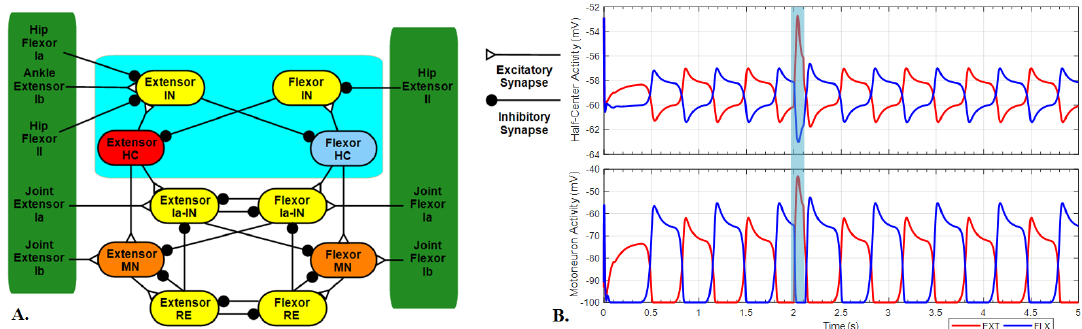
Figure 1. ( A ) Single limb joint control network. ( B ) Neuron activities of half-center neurons and motoneurons without feedback. Excitatory stimulus with a current of 2 nA applied to an extensor half-center neuron from 2 to 2.1 s (blue area). EXT: Extensor; FLX: Flexor; HC: Half-center neuron; IN: Interneuron; MN: Motoneuron; RE: Renshaw cell.